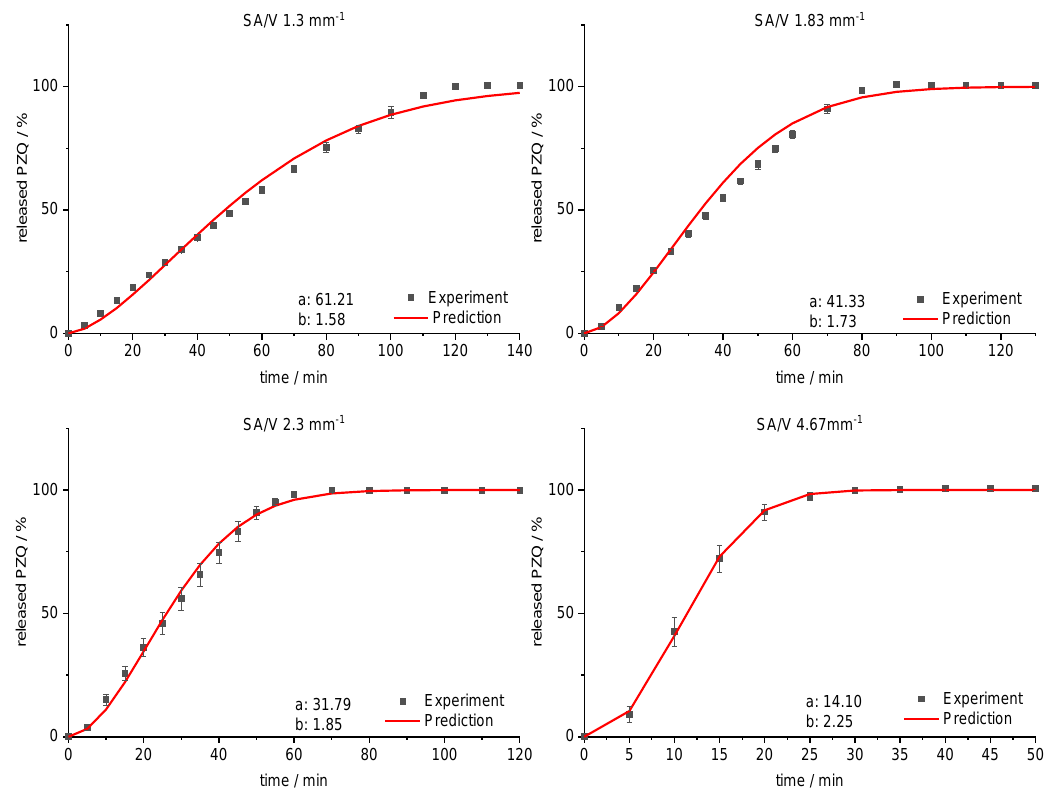
Figure 12. Predicted PZQ release vs. experimental PZQ release for SA/V ratios of 1.3 mm − 1 , 1.83 mm − 1 , 2.3 mm − 1 and 4.67 mm − 1 of the PVA-PZQ formulation.